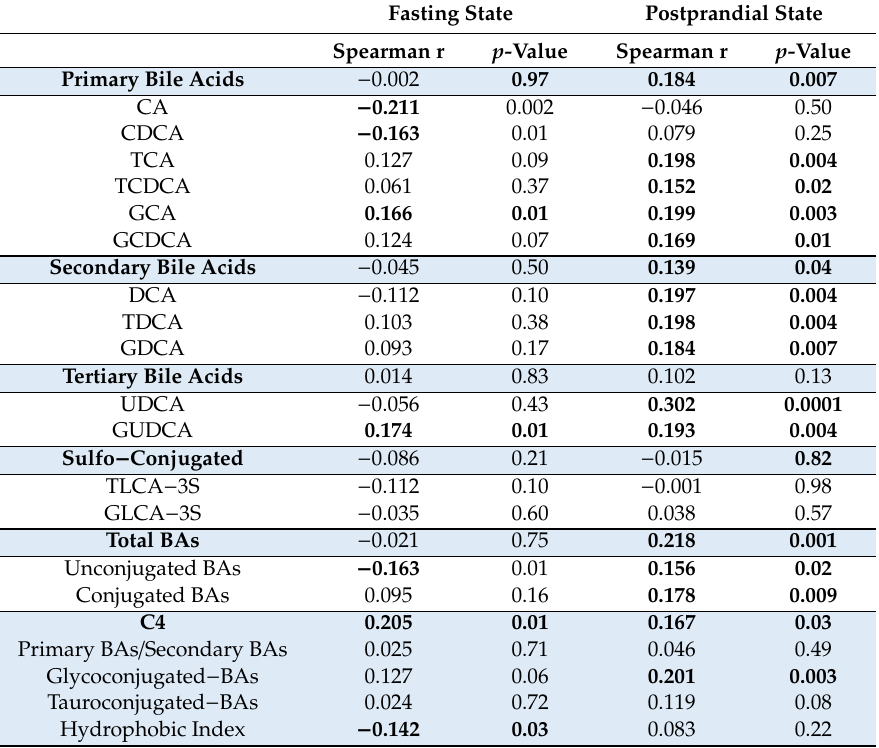
Table 3. Relationship between circulating levels of bile acid species and triglycerides in both fasting and postprandial